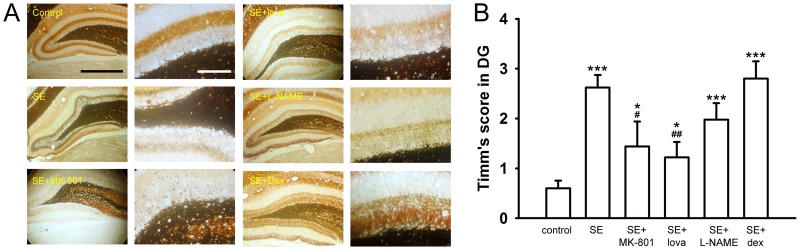
Timm’s stain under different treatments in the DG.(A) The Timm’s score was significantly increased after SE induction. MK-801 and lovastatin significantly decreased Timm’s score after SE induction. However, L-NAME and dexamethasone did not show any effect. Scale bar, 200 µm in the left panels and 100 µm for the right panels. (B) Summary data showing the mean Timm’s score between control and experimental groups in the DG. (*compared with control group; #compared with SE group).